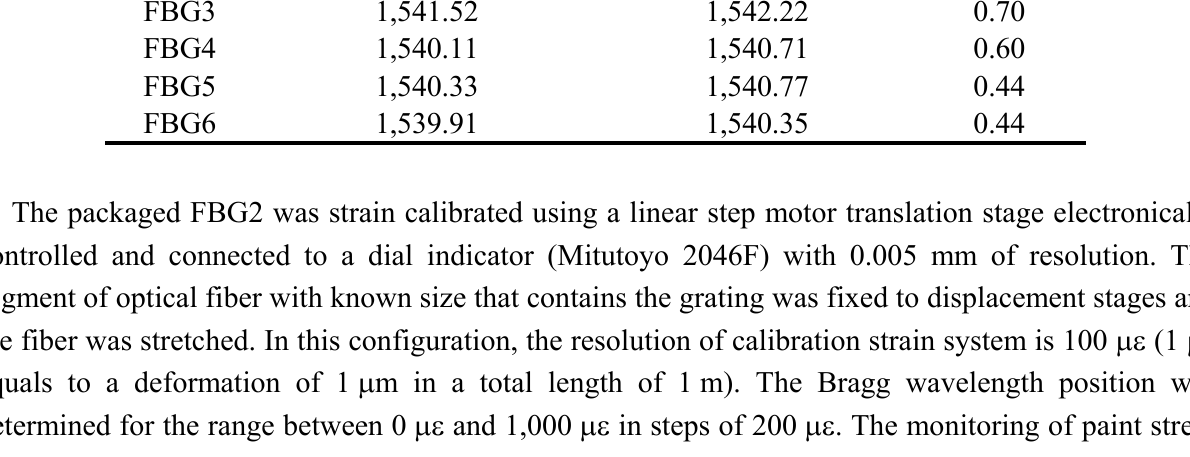
), before and after packaging, and the value of its red B